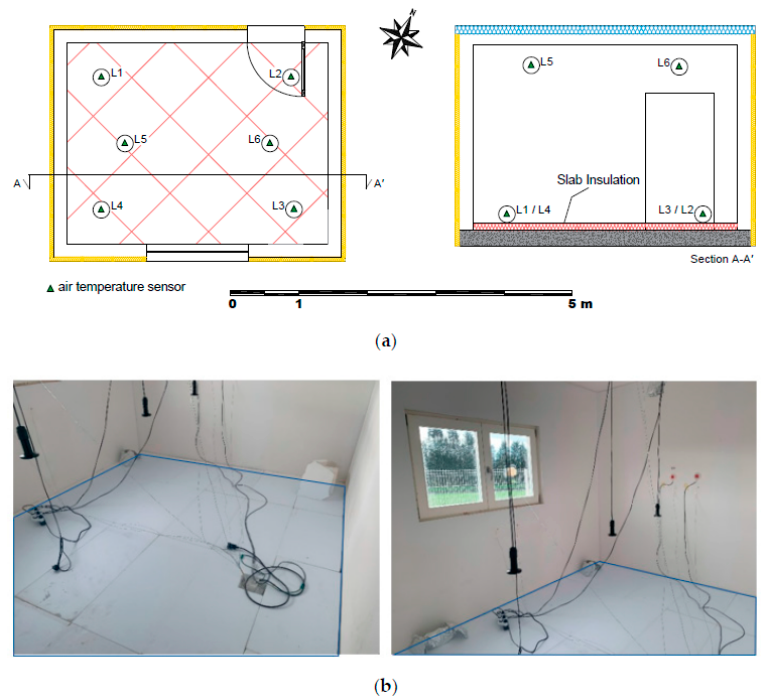
Figure 1. Experimental test cells (Setup 1): ( a ) plan view and section A-A ′ indicating the monitoring positions; ( b ) expanded polystyrene boards completely covering the ground slab.